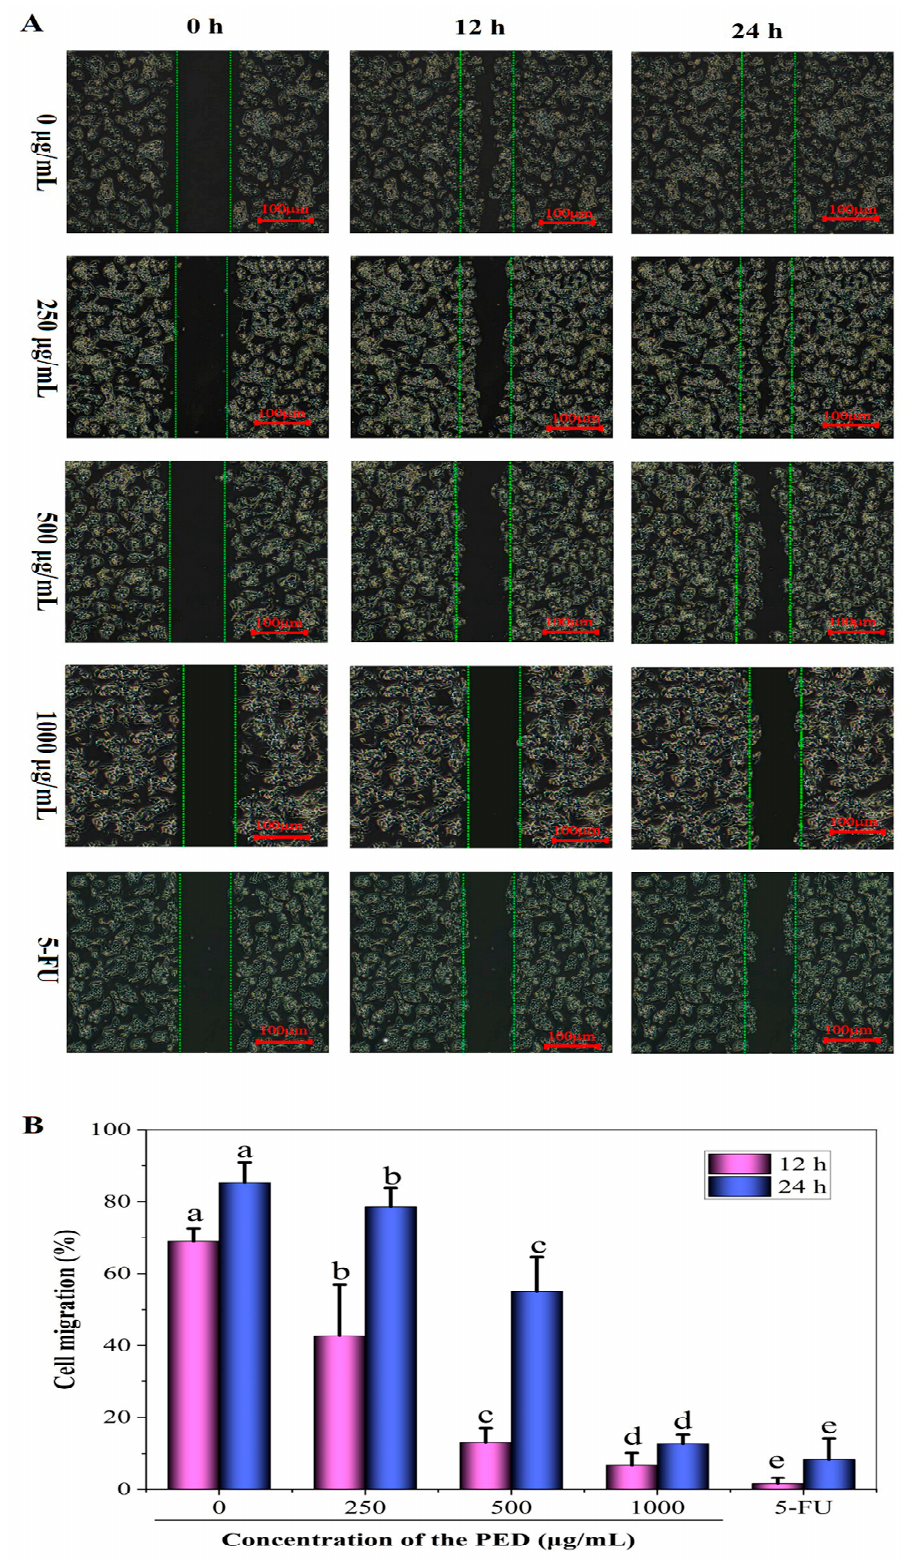
Figure 10. Effect of PED on the cell migration of HepG2 cells. ( A ) Images of PED-treated HepG2 cells monolayers at different time intervals (0, 12 and 24 h). ( B ) Quantitative measurement of HepG2 cells migration after treatment with PED. Different lowercase letters indicate significant differences ( p < 0.05).